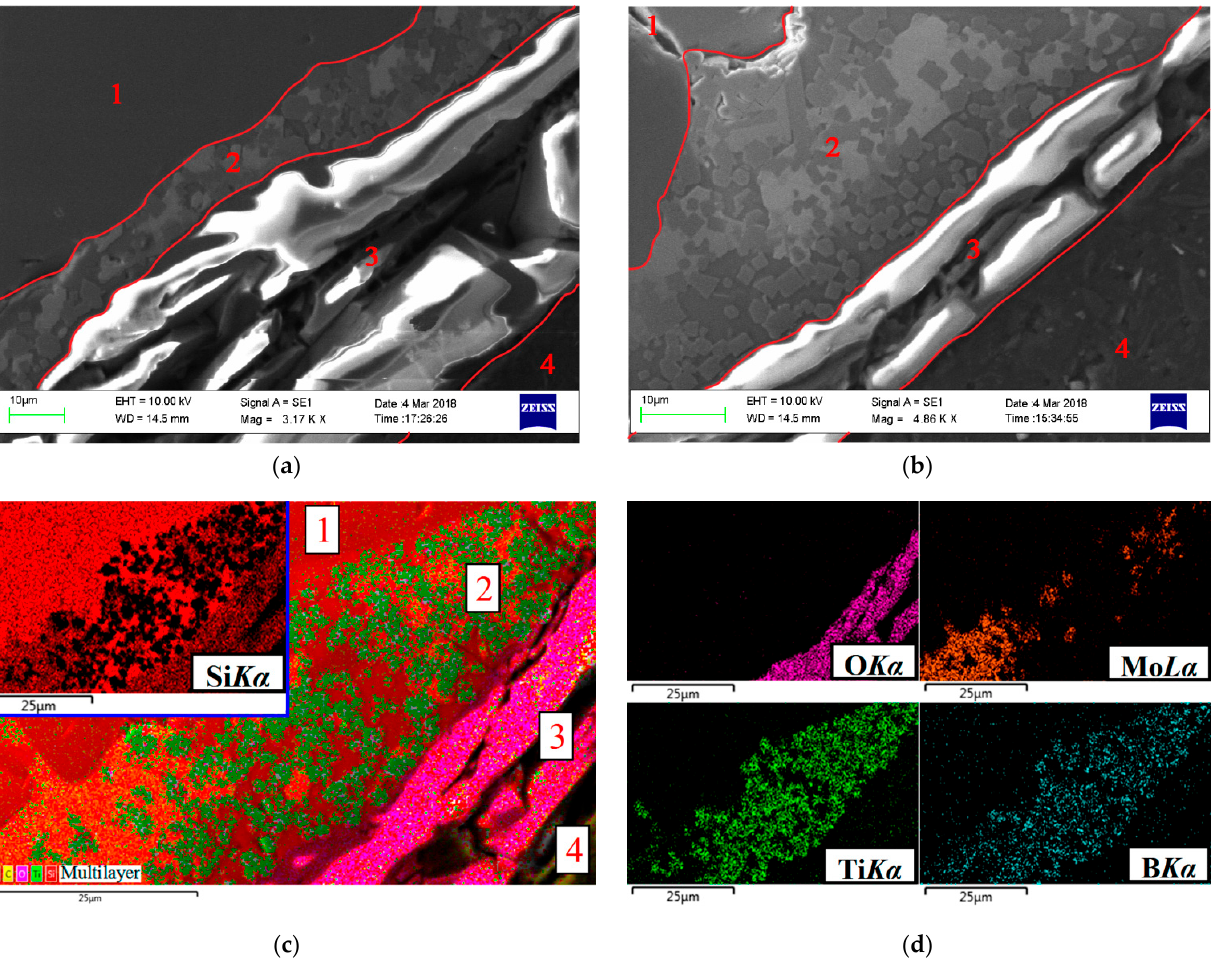
Figure 9. Microstructure ( a , b ) and distribution of elements in characteristic X-ray radiation ( c , d ) in cross-sections of Si–TiSi 2 –MoSi 2 –TiB 2 –CaSi 2 coating areas after firing tests according to the regime shown in Figure 4a: ( a ) in the vicinity of the epicenter of the flow; ( b ) at a distance of 10 mm from the critical point; ( c , d ) at a distance of 7.5 mm from the critical point: 1—SiC-backing layer, 2—unoxidized coating, 3—oxide film, 4—resin.